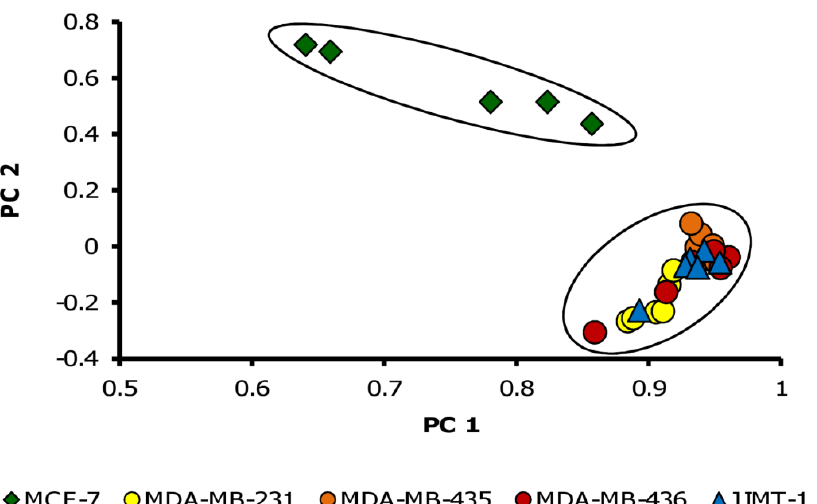
Figure 1. Principal component analysis (PCA) of metabolite profiles from the five breast cancer cell lines. MCF-7 is clearly separated from the other cell lines. PC 1 includes 81% of variability, PC 2 7.5%. n = 6 for each cell line, only metabolites with significant differences between at least two cell lines ( p < 0.05; mean ratio > 2) were included (n =